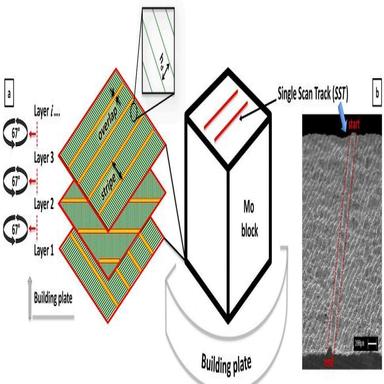
(a) scan strategy used for Mo production. (b) scheme of the single scan track (SST) produced on top surface of Mo block.